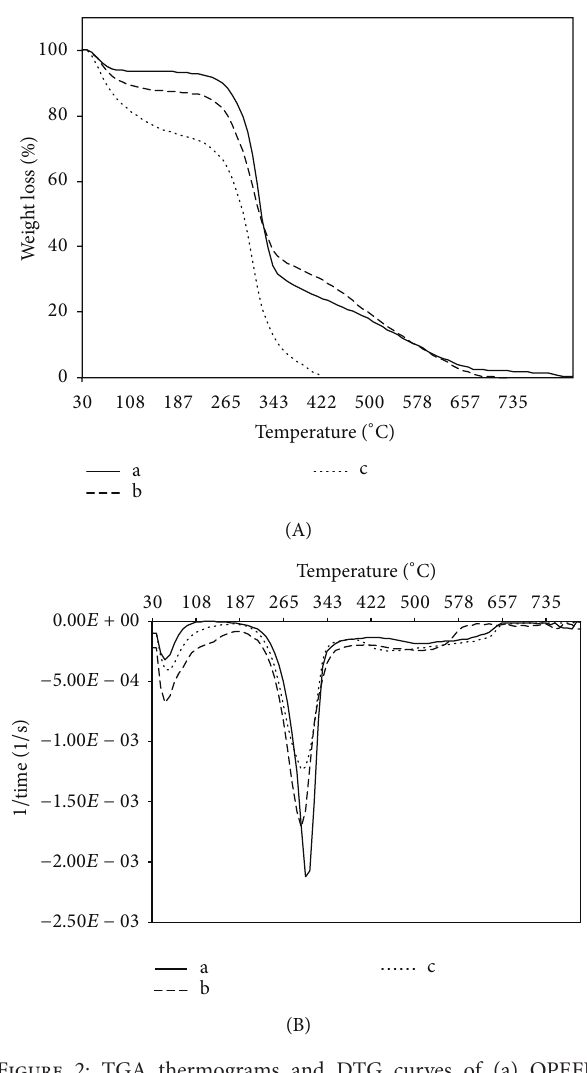
lignin and hemicellulose were successfully removed. Thermal